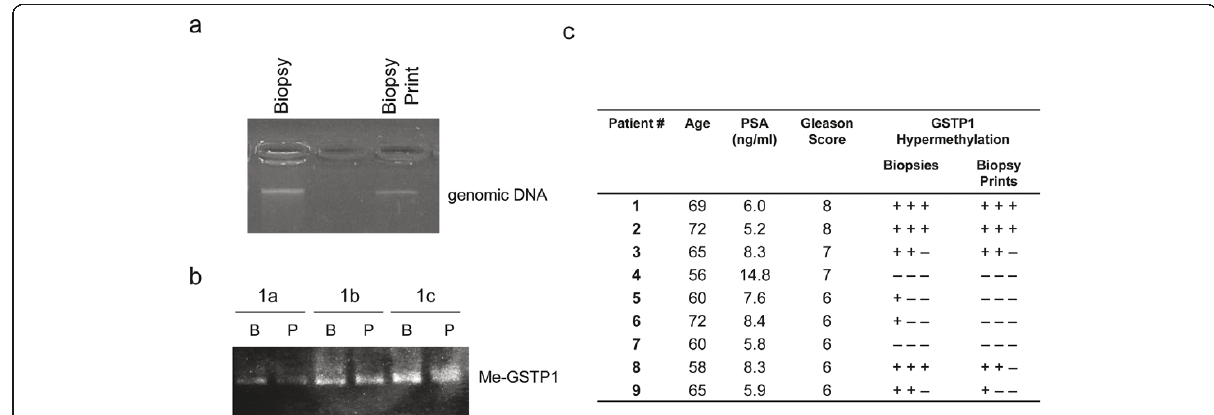
Figure 3 DNA extraction from biopsy print and GSTP1 hypermethylation analysis . (A) DNA was obtained from the biopsy print and from the corresponding biopsy and 1/5 of total DNA volume was subjected to electrophoresis run in 1.8% w/v agarose gel. (B) PCR-amplified products from bisulfite converted DNA were subjected to electrophoretic separation in agarose gel. DNA was extracted from three different biopsy prints (P) and the related biopsies (B) of the same patient (#1 as in 3C). (C) GSTP1 methylation status in PCa patients evaluated in three different biopsy prints and related biopsies (+ = GSTP1